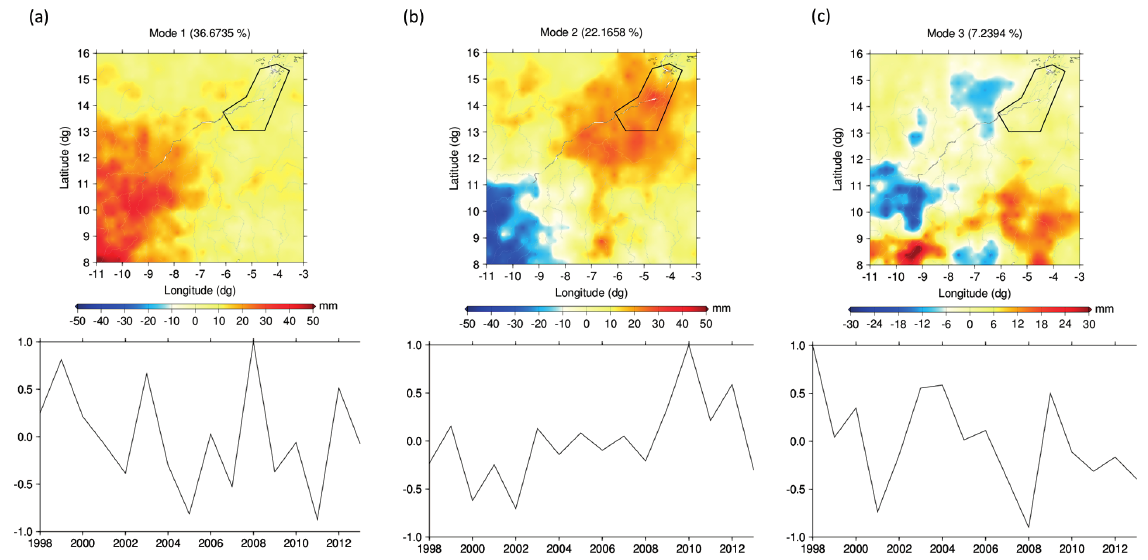
Figure 15. Three first Empirical Orthogonal Functions (EOF) modes ( a – c ) of precipitation over the Region of Interest, calculated with Tropical Rainfall Measuring Mission (TRMM) 3B43